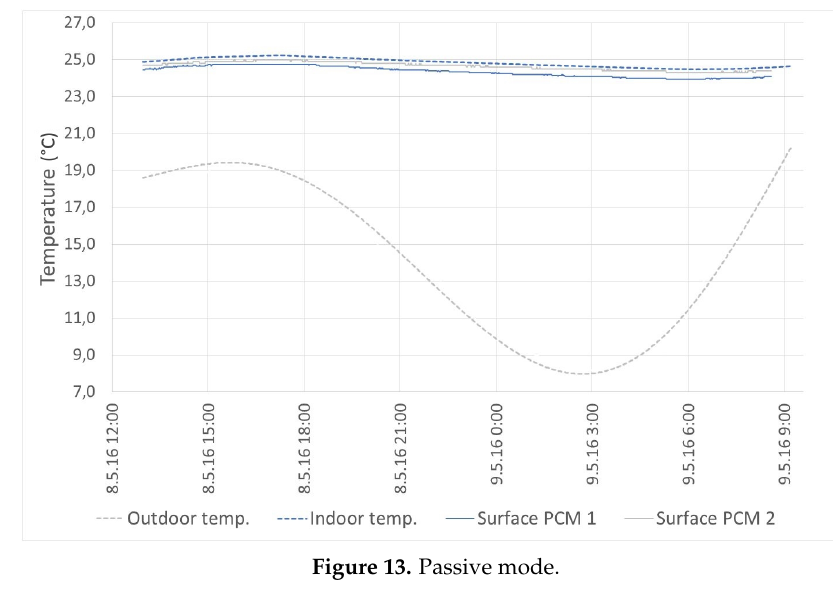
Figure 13. Passive mode.